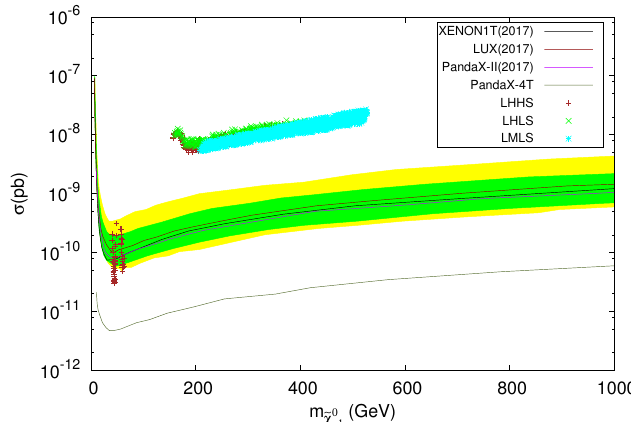
Figure 9 . Same as in (cid:12)gure 8 but for LHHS, LHLS ans LMLS models.